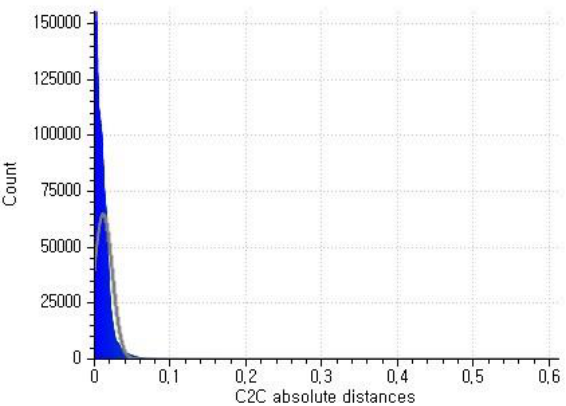
Figure 9. There are the figures of the 3D model of the façade based on method(A) and (B) from the top. Third and fourth figures are the result of